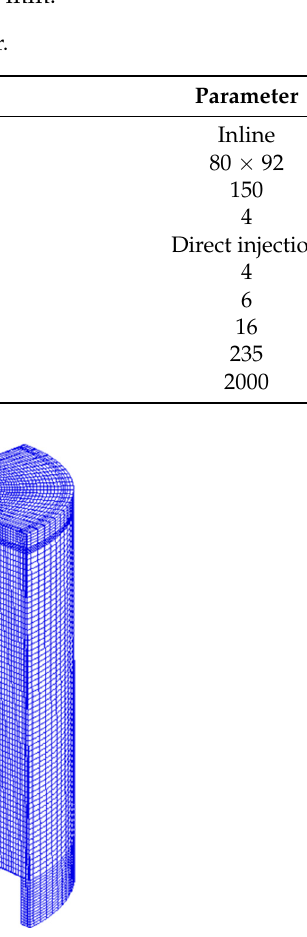
Figure 1. One-quarter model grid of combustion chamber.